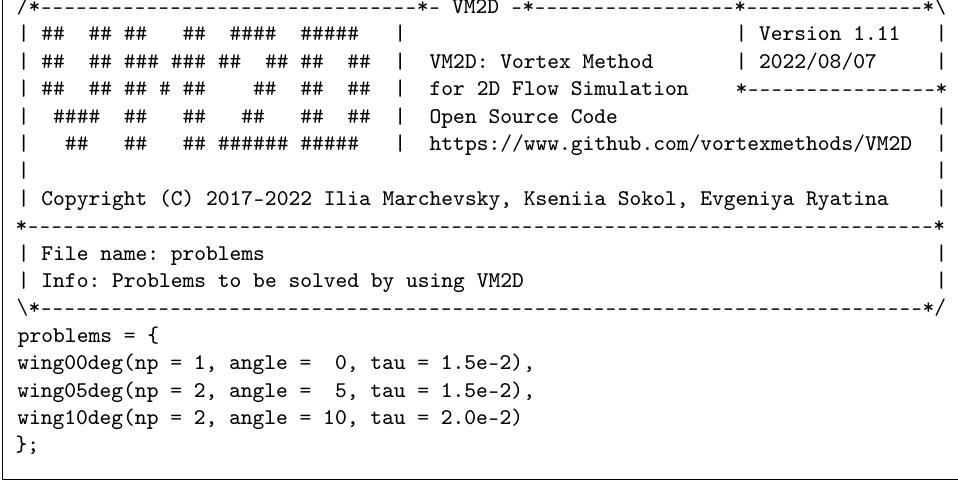
Figure 13. The typical structure of the problems